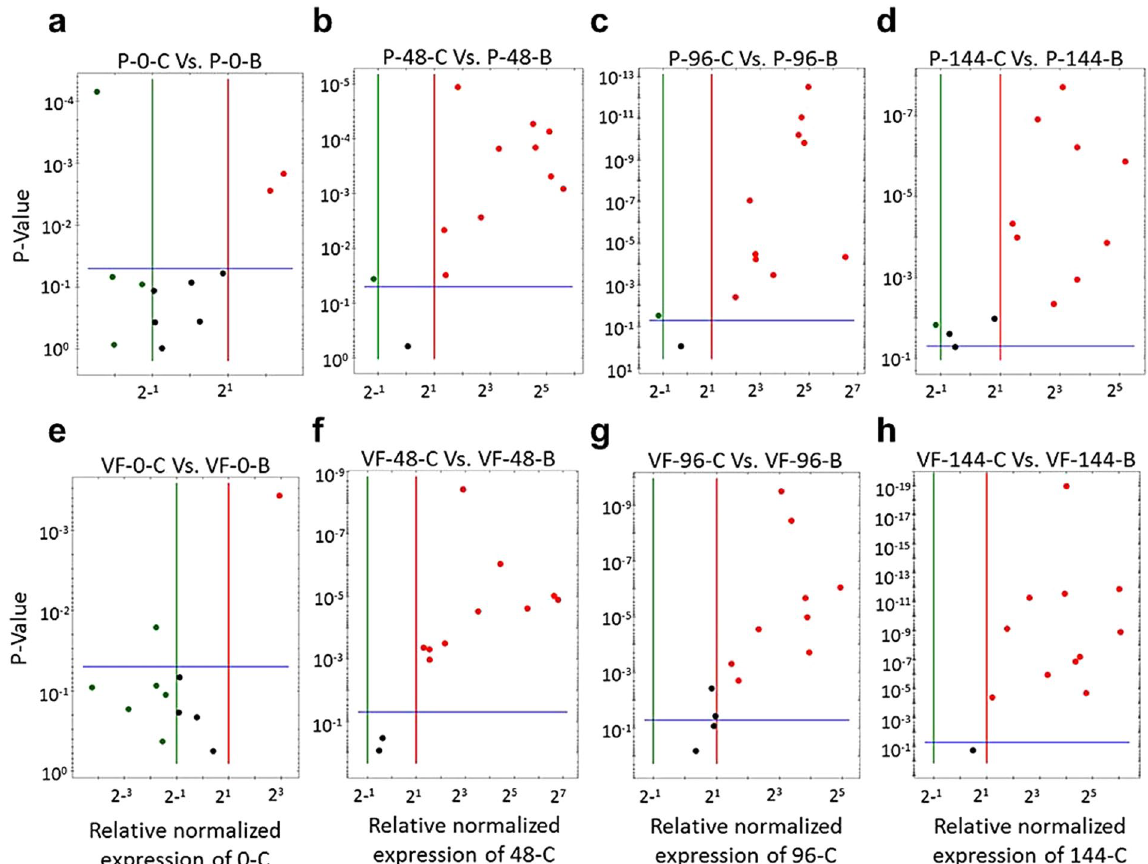
Figure 3. Differential expression of disease-responsive genes in the inoculated stem tissues of ‘Valley Forge’ and ‘Princeton’. ( a – h ) Volcano plots showing the clusters of genes expressed differentially in bark vs. core tissues of ‘Princeton’ (upper panels) and ‘Valley Forge’ (lower panels) at different time points post-inoculation. The horizontal line marks the threshold ( P < 0.05) for defining a gene as up-regulated in bark (green) or core (red), with a combined change >